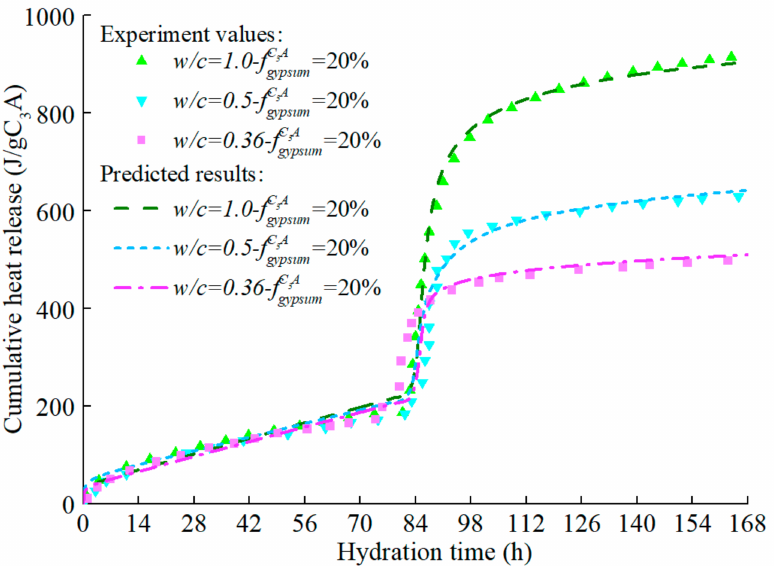
Figure 18. Hydration Heat of C 3 A in different Water–cement ratio C 3 A-Gypsum system (coarse